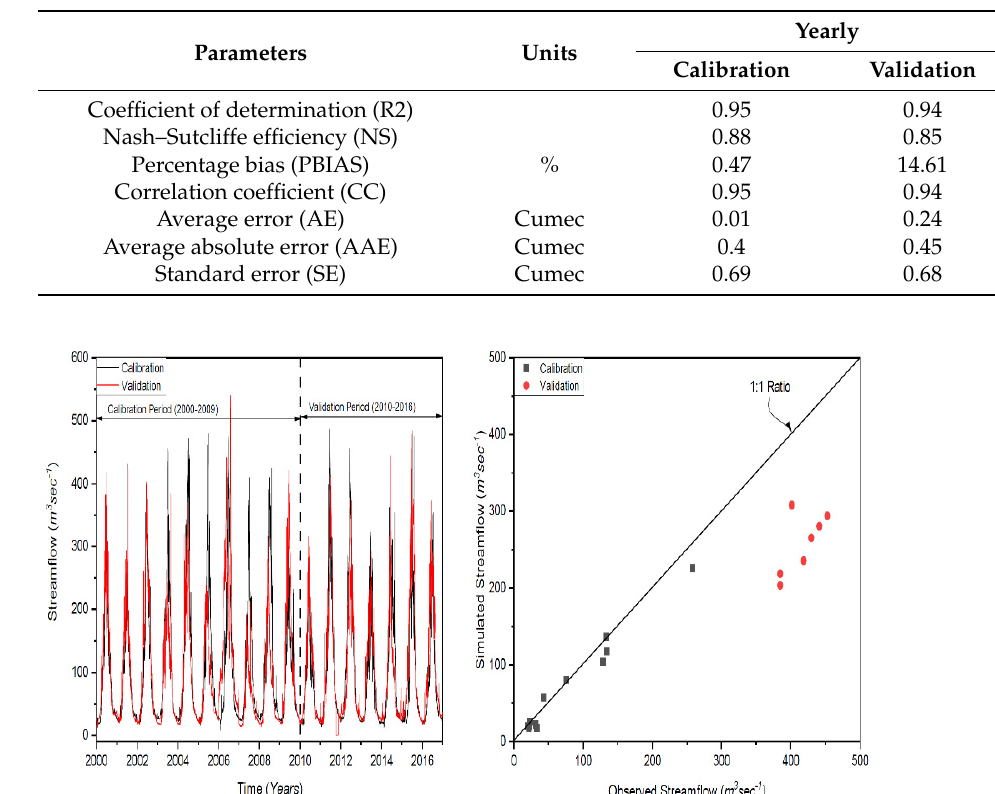
Figure 4. Validation and calibration of the HBV by year for Gari-Habibullah.